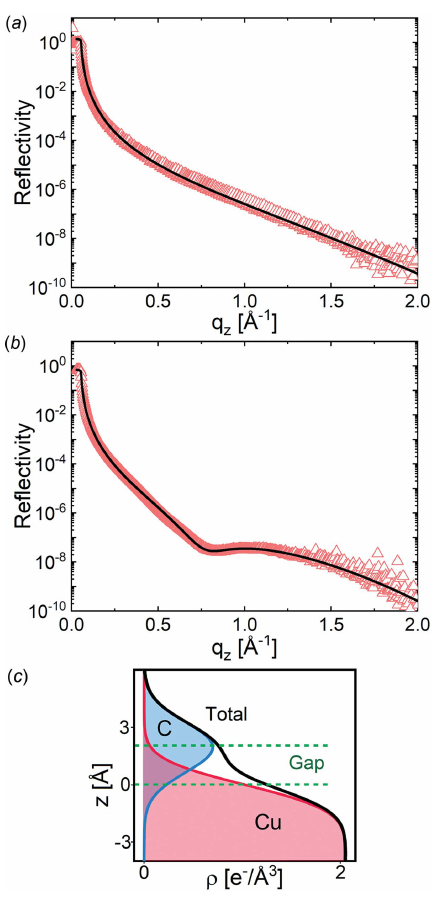
Figure 8 Reconstructed XRR curves (triangles): ( a ) liquid copper and ( b ) liquid copper with graphene. The solid line is the best fit. ( c ) Resulting electron density model of the graphene layer on the liquid copper split into the contributions of different components and the separation gap. The separation gap is defined as Gap = t S + t G